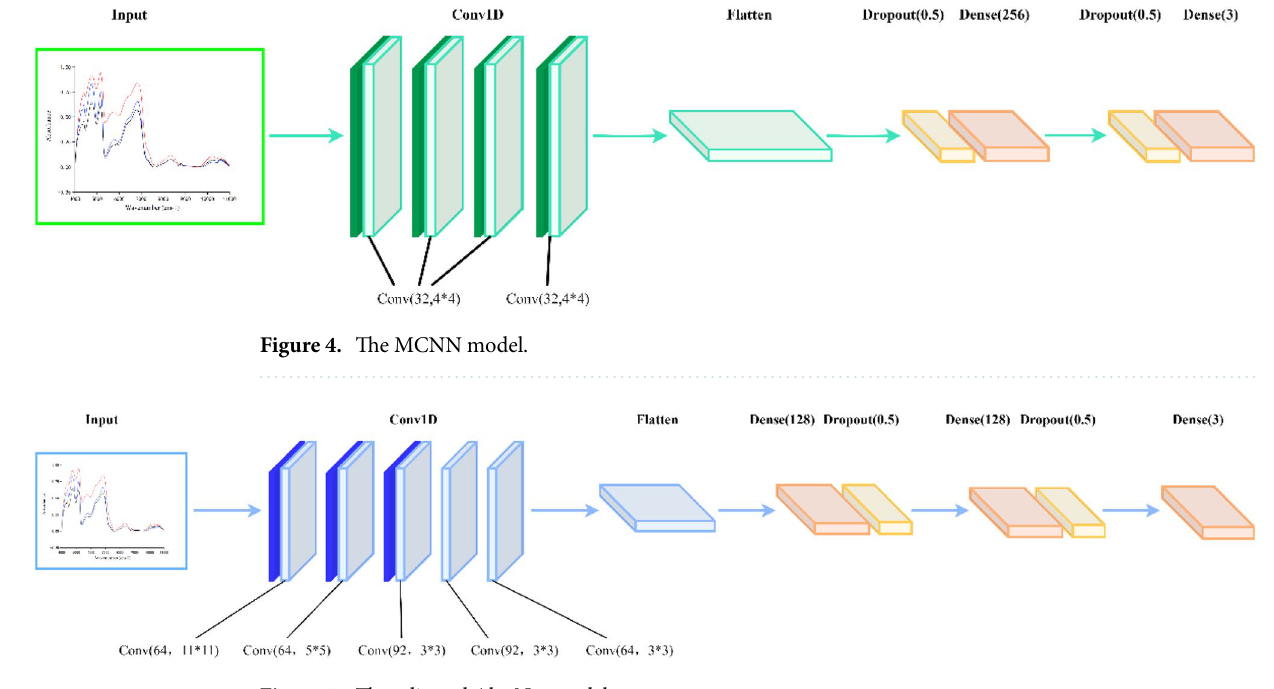
Figure 5. The adjusted AlexNet